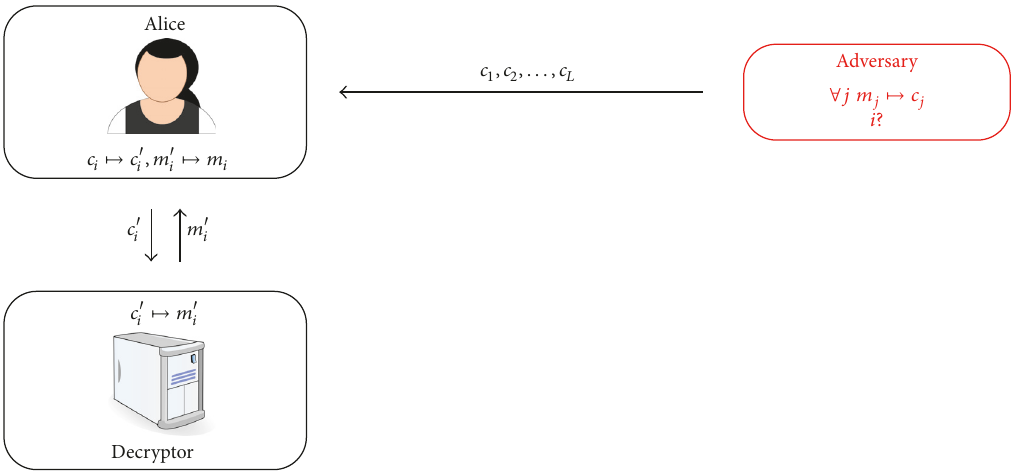
Figure 3: Malicious encryptor. The adversary attempts to learn which message was chosen by Alice.